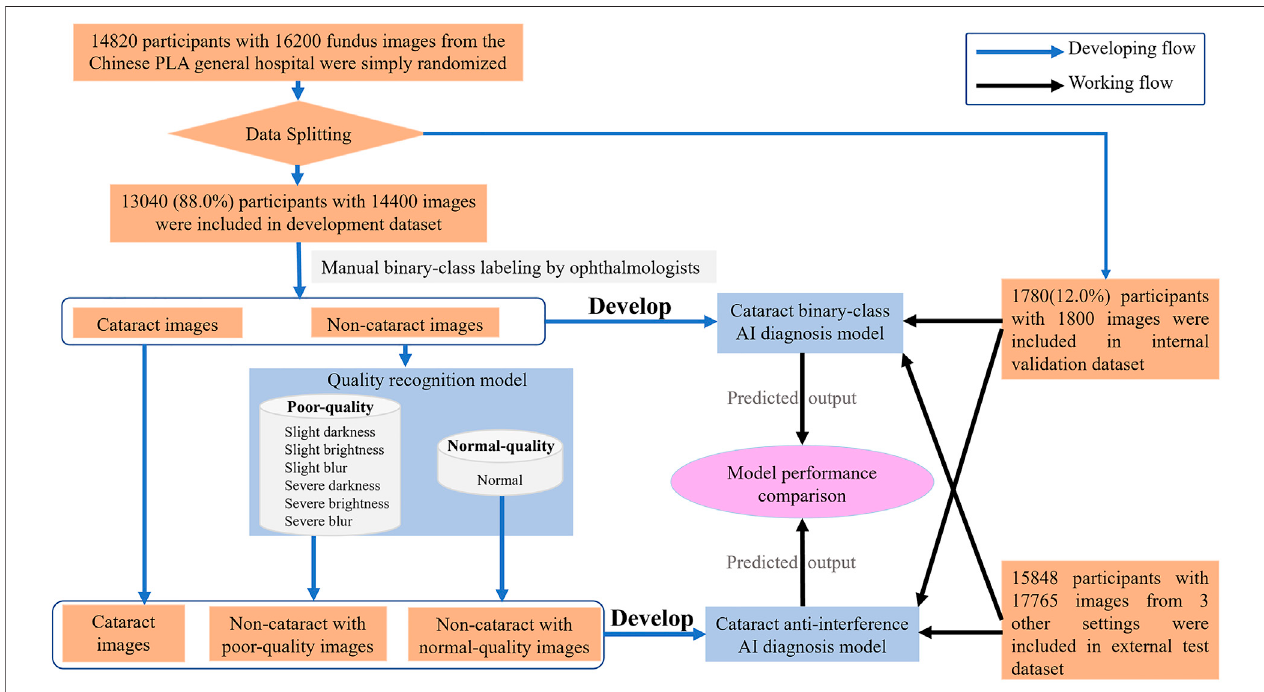
FIGURE 2 | Flow chart describing the datasets and methods used for our arti fi cial intelligence model.